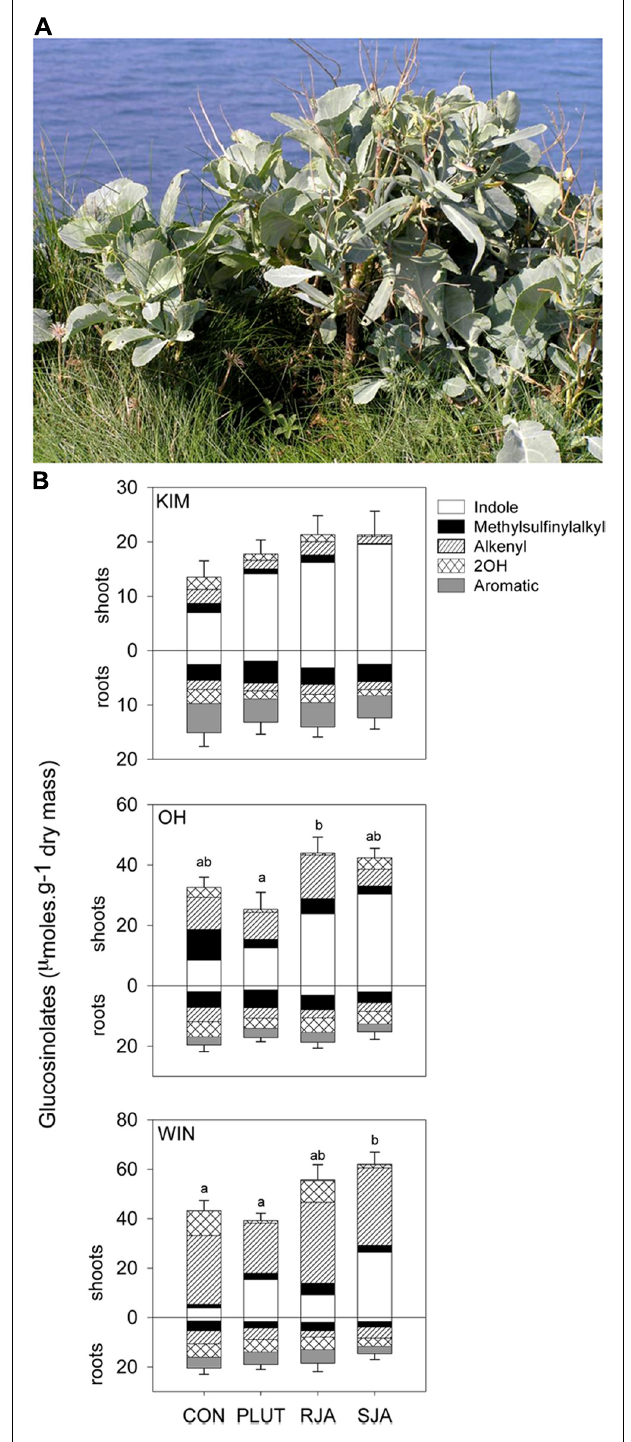
FIGURE 2 | (A) Brassica oleracea . (B) Shoot and root glucosinolate levels (mean + SE of mean total, n = 4 or 5) of Brassica oleracea plants originating in Dorset, England from three wild populations located at sites called Kimmeridge (KIM), Old Harry (OH), andWinspit (WIN), respectively. Glucosinolates were classified according to their amino acid origin into indole, aromatic and aliphatic GS.The latter group was further divided